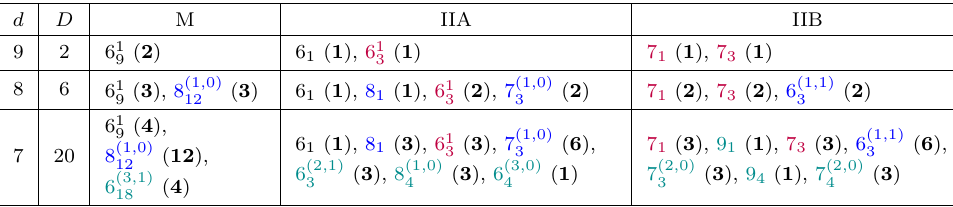
Table 13 . Branes in the 6-brane multiplet.